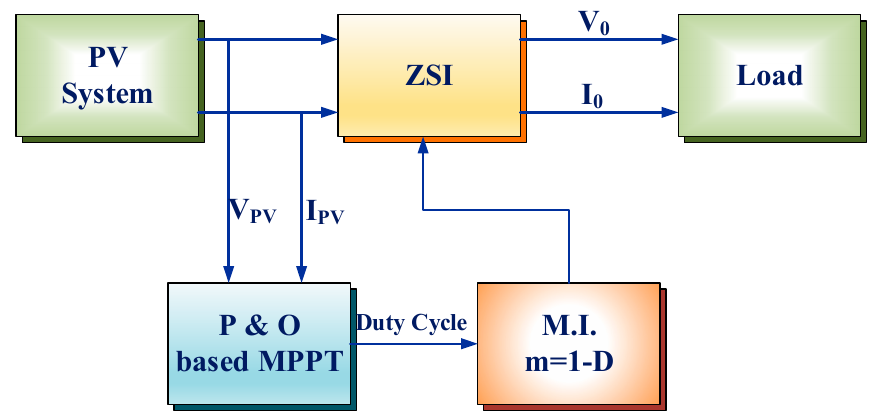
Figure 4. Block diagram of Perturb and Observe method.